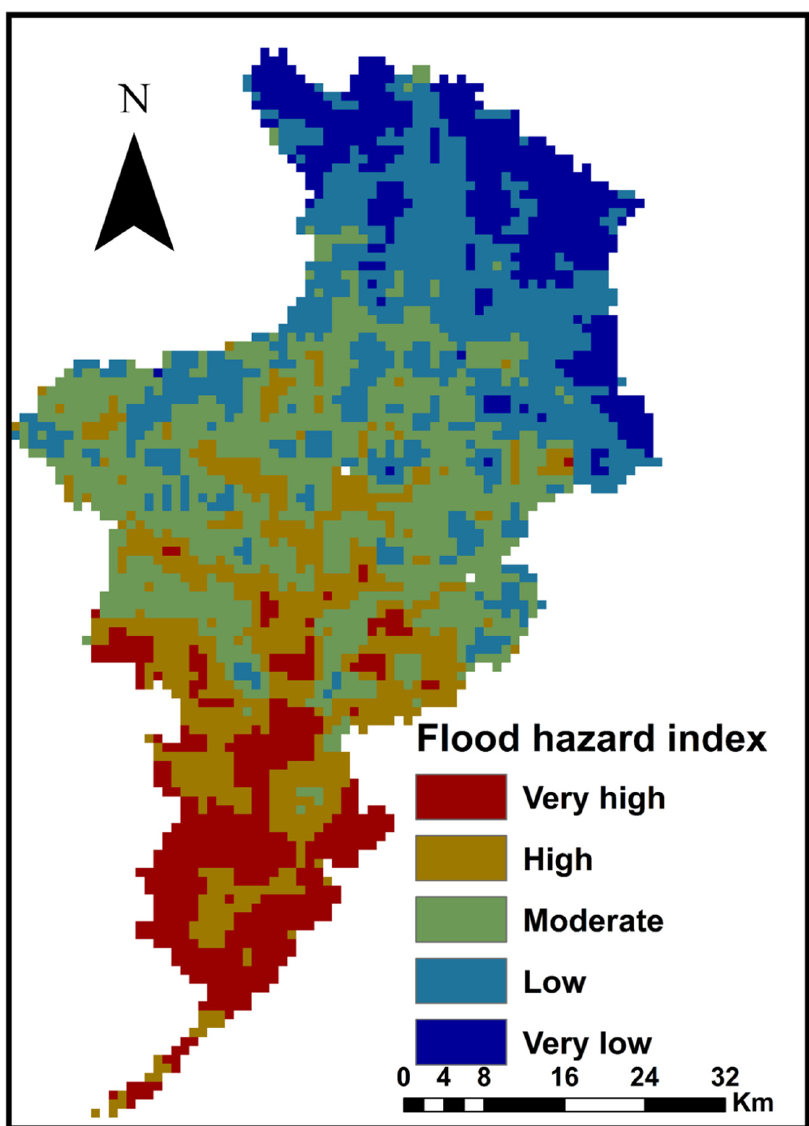
Figure 7. Flooding hazard map of the watershed. Validation and Modeling of Flood Hazards Using